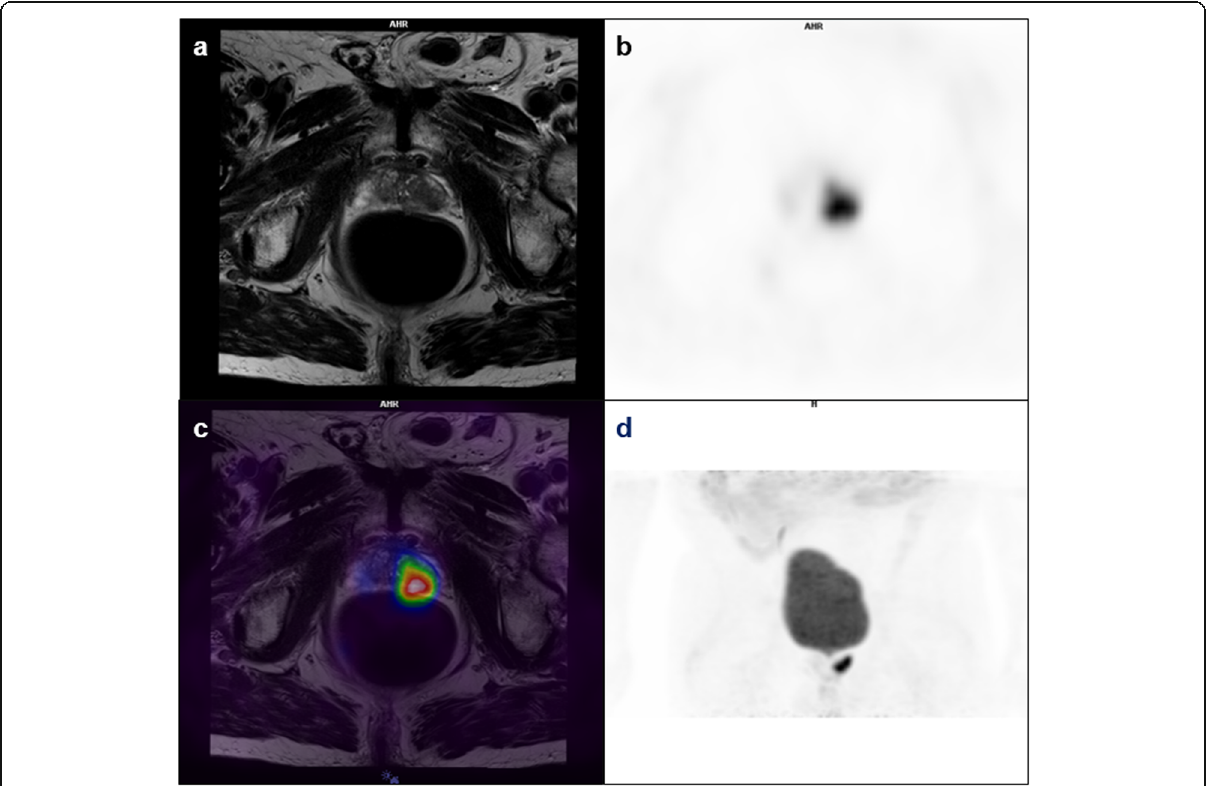
Fig. 1 Primary prostate cancer patient (PSA 5.57 ng/mL) presenting an intense focal 68 Ga-PSMA-11 uptake in the left lobe of the prostate (SUV 45 – 60 min: 13.27). MR T2-weighted image ( a ), averaged dynamic PET 45 – 60 min post-injection ( b ), PET/MR fused image ( c ), and